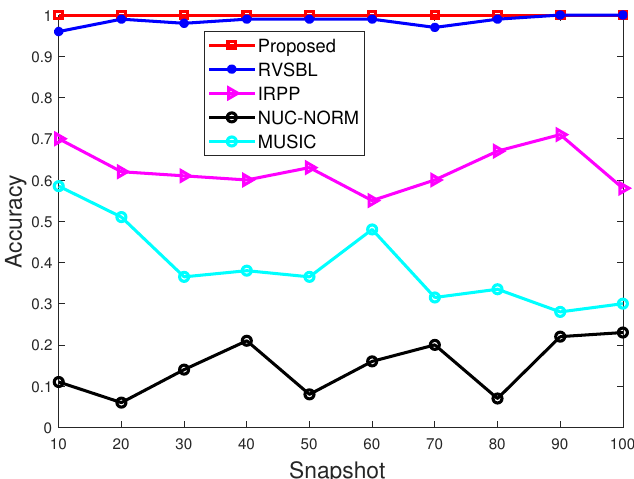
Figure 5. Accuracy with different